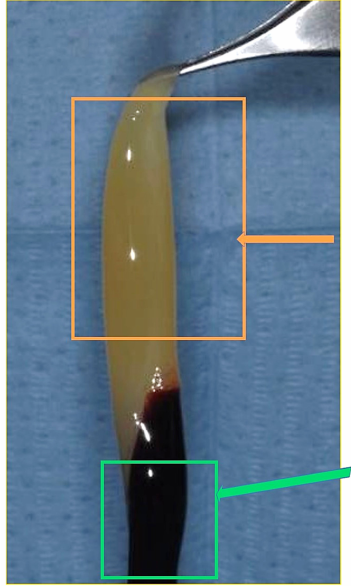
Figure 1. Autologous platelet gel (APG) immediately extracted from the vial appeared composed of two portions, one yellow portion and one red portion. B. The yellow portion (orange arrow) and red portion (green